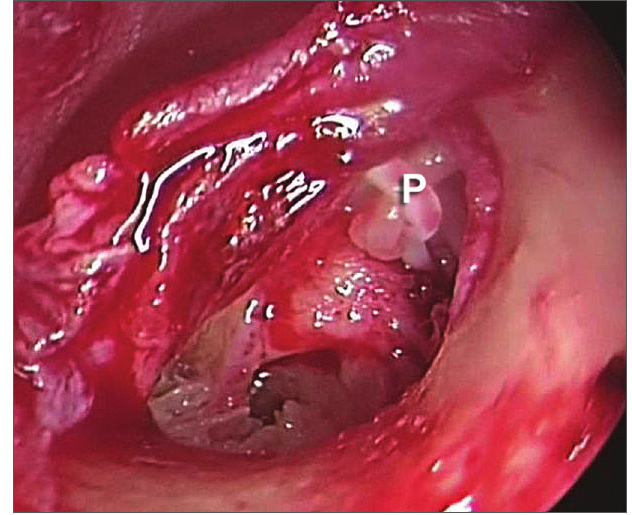
Figura 4. Visão endoscópica (instrumento com 30 graus de angulação) da prótese de Teflon (P) em local.